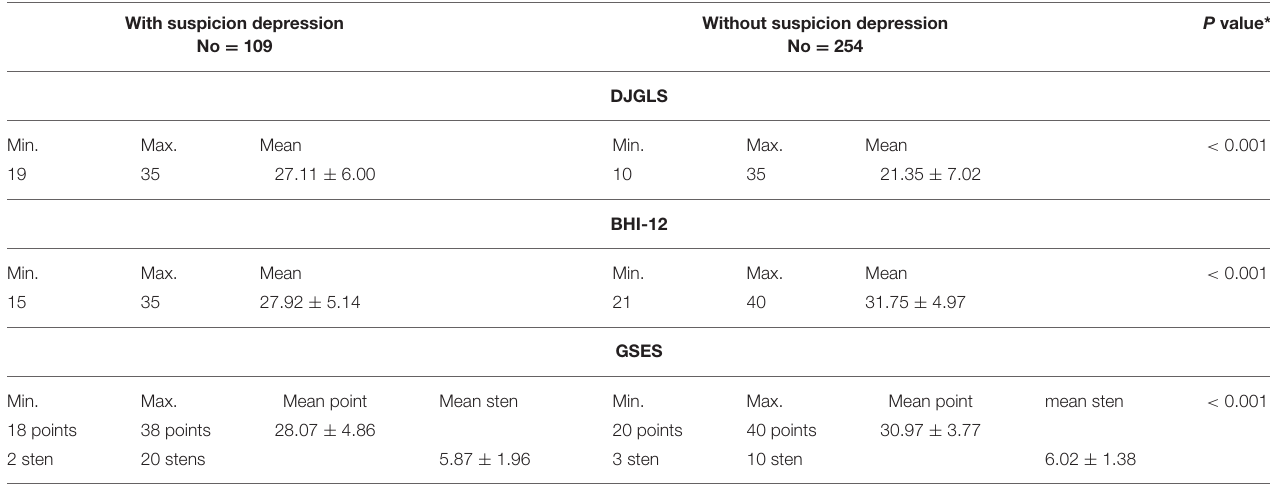
TABLE 3 | The results of psychometric scales in the group of respondents. With suspicion depression No =